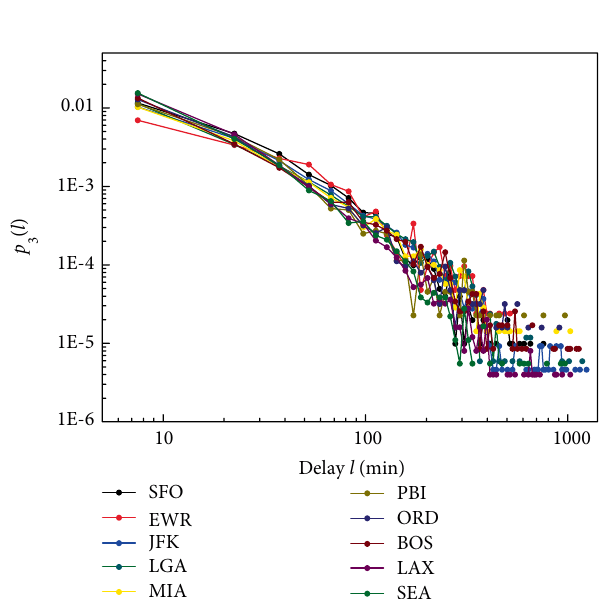
Figure 3: Log–log plots of departure delay distribution 𝑝 10 busy airports with the highest delay